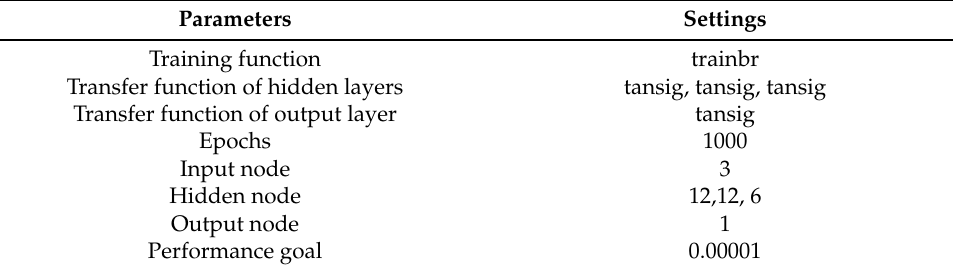
Table 3. Parameters and settings of training network.